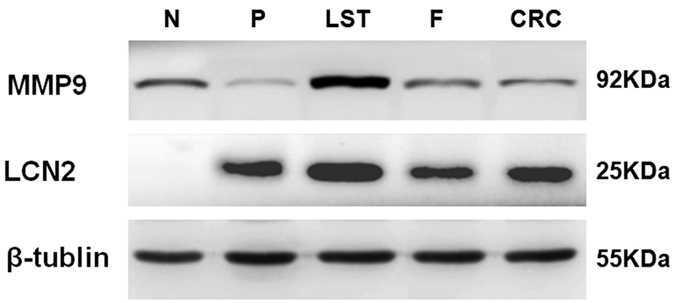
Western blot validation of LCN-2 and MMP-9 in different groups.The expression levels of LCN-2 and MMP-9 were significantly higher in LSTs compared with other groups (P < 0.05), which were in line with the iTRAQ results. β-tubulin was used as a loading control. LSTs: laterally spreading tumors, P: protruded-type adenomas, F: small flat adenomas, N: normal controls, CRC: TNM stage I colorectal carcinomas.